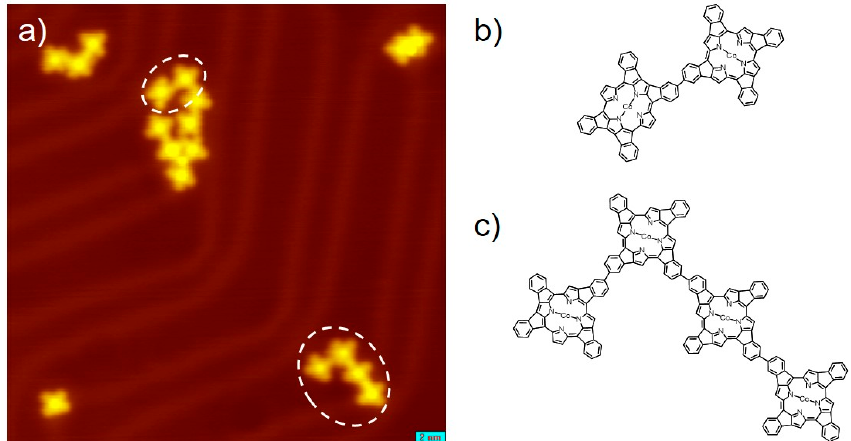
Figure A2. ( a ) STM image of the sample surface of Figure 1c further annealed at about 750 K; ( b , c ) proposed chemical structures for two intermolecular coupling products marked by the white dashed ovals in ( a ). Imaging conditions: − 0.3 V, 20 pA. Image size: 30 × 30 nm 2 .